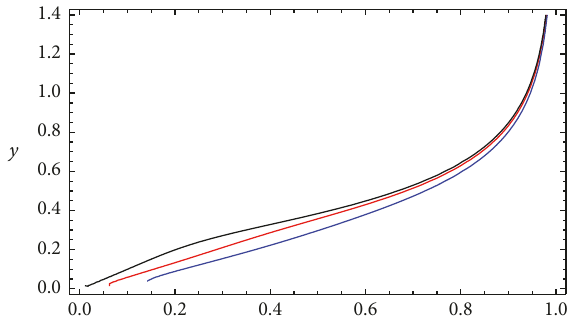
Δ̃𝑄 = 0.05 Δ̃𝑄 = 0 (blue), (red), and